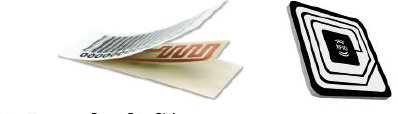
Figure 7: Example of Rfid tag.